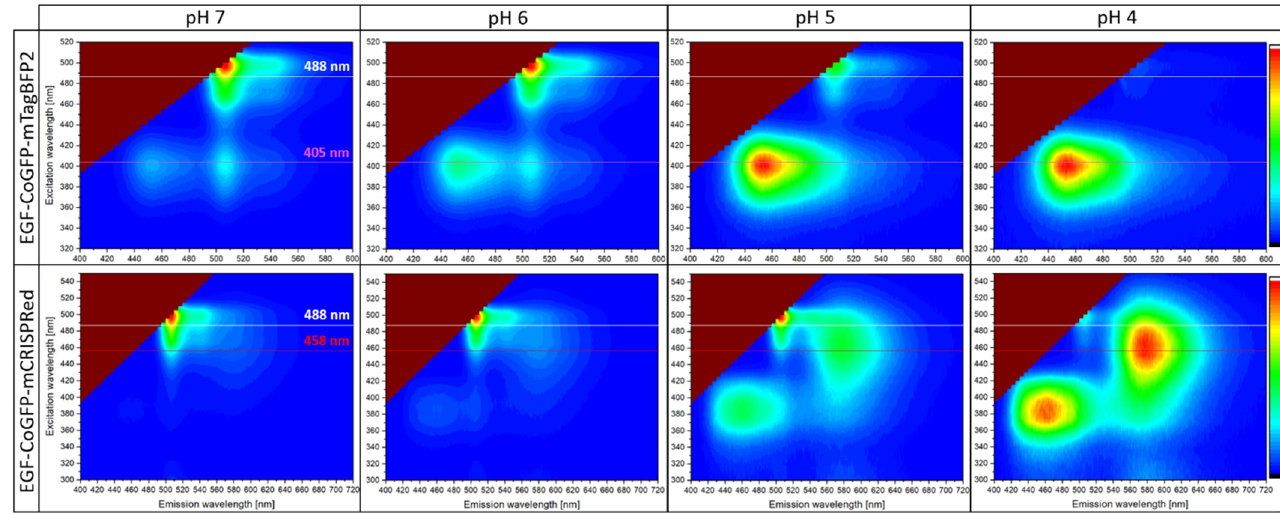
Figure 3. The 3D fluorescence spectra of EGF-CoGFP-mTagBFP2 and EGF-CoGFP-mCRISPRed at pH 7, 6, 5, and 4 were measured using a spectrofluorometer. Common suitable excitation wavelengths 405 nm (purple), 458 nm (red), and 488 nm (white) are marked. Intensities vary significantly and were normalized to the maximum for each plot. Plots were generated using OriginPro.